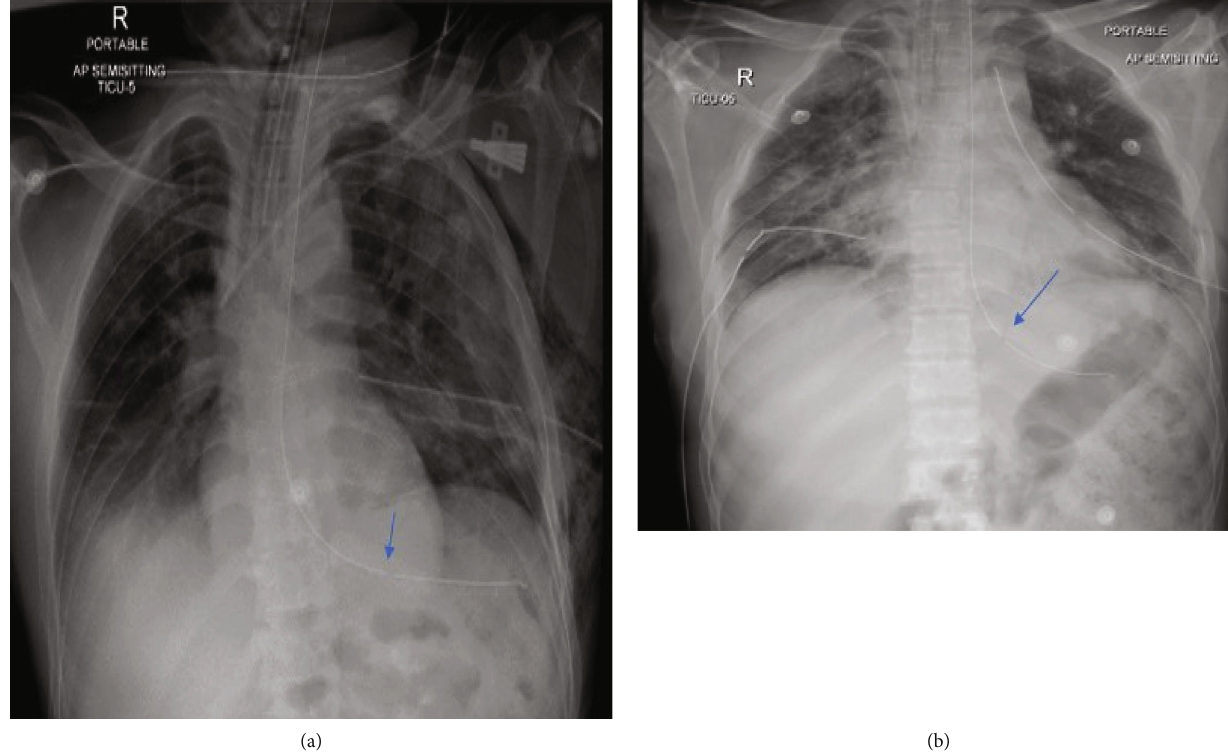
Figure 2: Chest X-ray (a & b) shows endotracheal tube, orogastric tube and left thoracostomy tube: The side hole of the feeding tube seen overlying the gastro-esophageal junction (arrows).